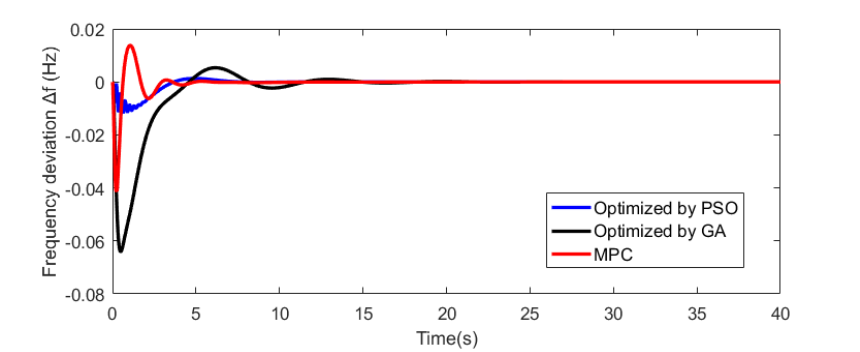
Figure 11. Frequency deviation in Area 2 for the second case.